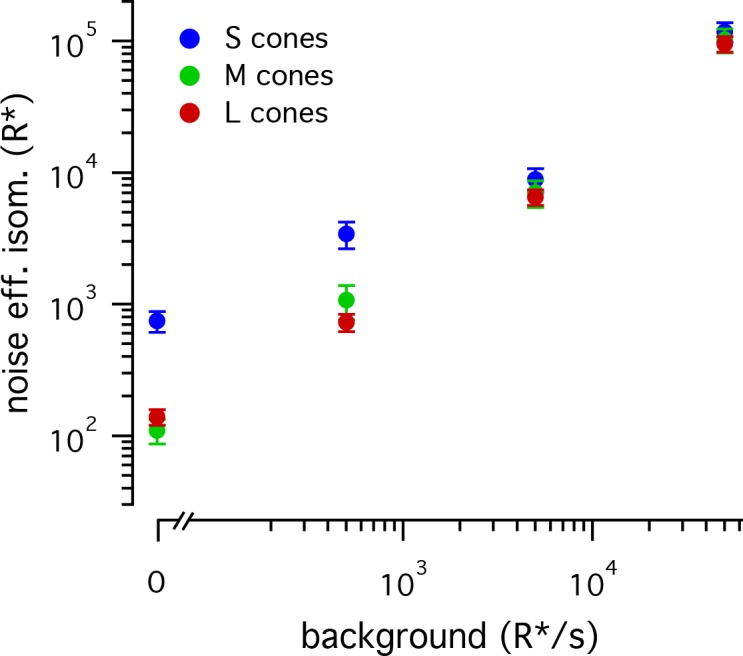
Noise-effective isomerizations across cone types Effective noise-isomerization levels across backgrounds.Values were computed as number of isomerizations necessary to produce an equivalent power to the noise in the range of 2 to 16 Hz. Points represent mean ±sem. For S cones (n = 9), values were 737 ± 136 R* in darkness, 3422 ± 780 R* at 500 R*/s, 8914 ± 1848 R* at 5000 R*/s, and 117,419 ± 19,785 R* at 50,000 R*/s. For M cones (n = 9), values were 110 ± 23 R* in darkness, 3422 ± 780 R* at 500 R*/s, 7050 ± 1624 R* at 5000 R*/s, and 102,721 ± 21,195 R* at 50,000 R*/s. For L cones (n = 15), values were 139 ± 19 R* in darkness, 731 ± 110 R* at 500 R*/s, 6522 ± 879 R* at 5000 R*/s, and 95,295 ± 12,725 R* at 50,000 R*/s.